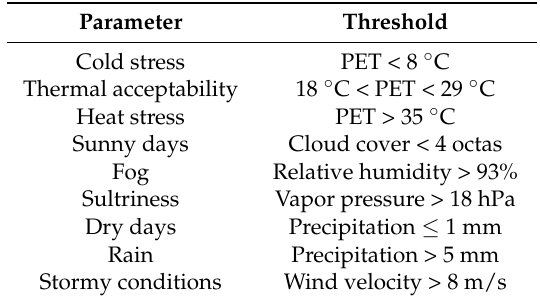
Table 3. Definition of parameters used in the Climate-Tourism-Information-Scheme